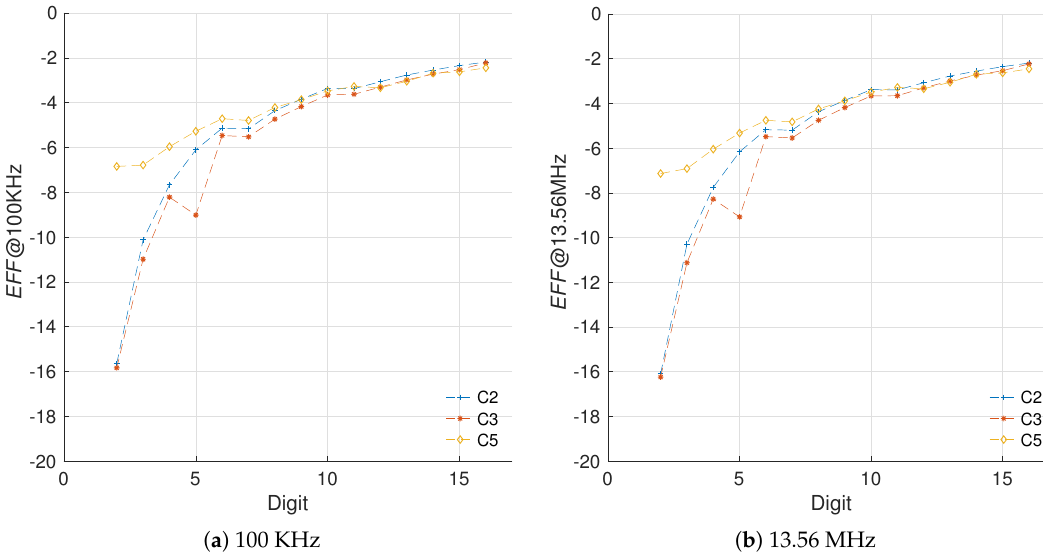
Figure 10. Evaluation of the efficiency metric for the different kP configurations using two operational